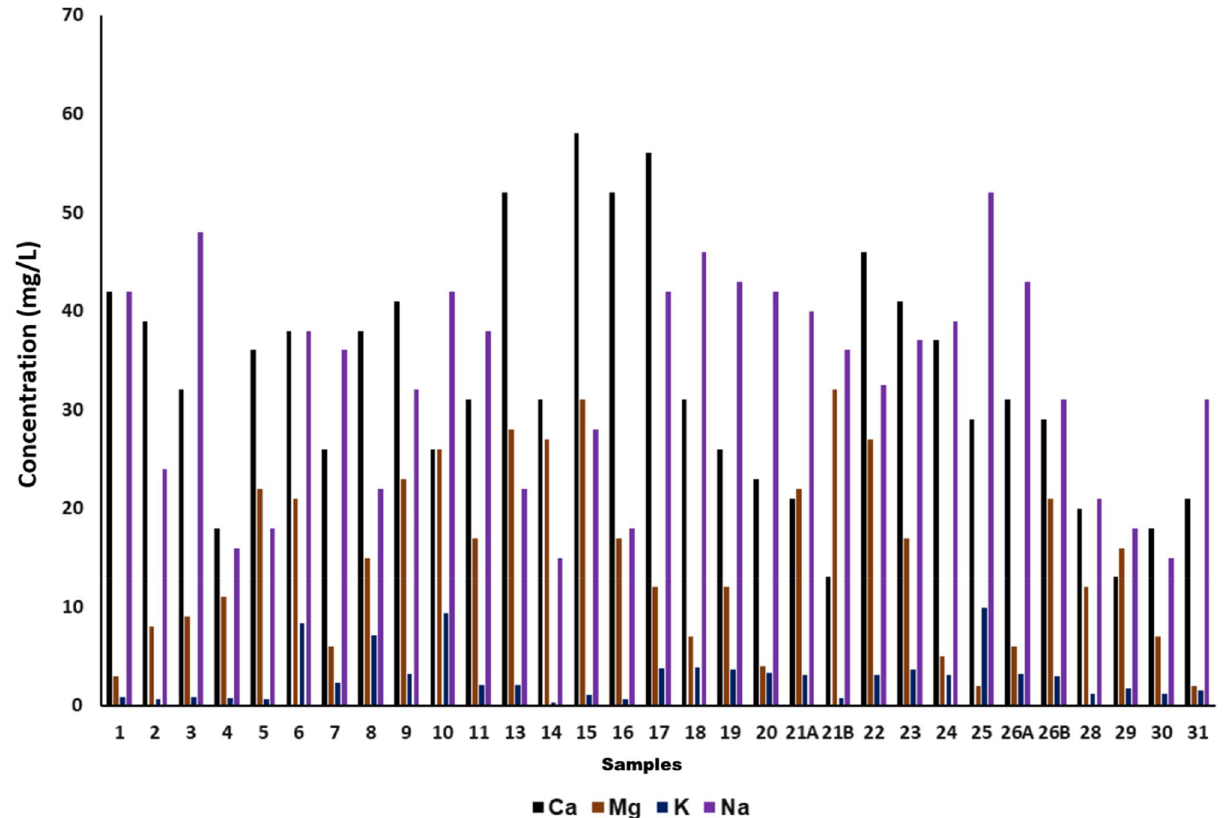
Figure 4. Calcium (Ca 2+ ), Magnesium (Mg 2+ ), Sodium (Na + ) and Potassium (K + ) of 31 water samples collected from